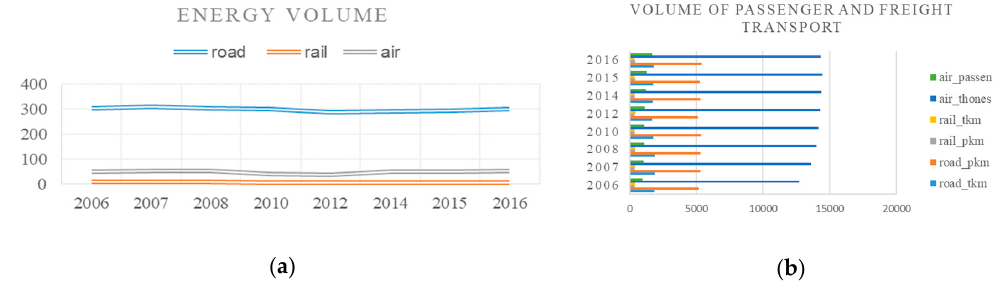
Figure 1. Trends of non-energy inputs for labor ( a ) and ( b ) number of assets.